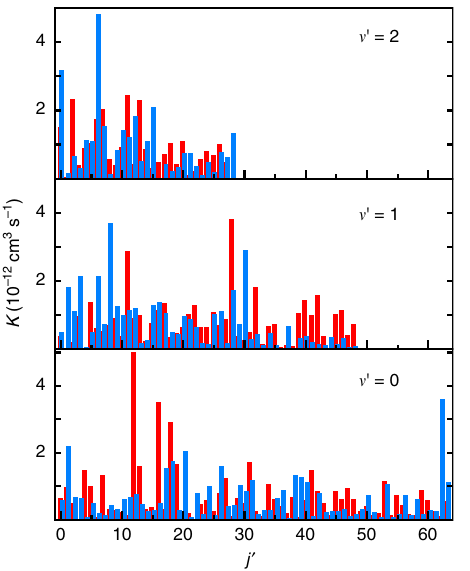
Figure 3 | Rotationally resolved rates. The state-to-state J ¼ 0 EQM reaction rate coefficients from the v ¼ 0, j ¼ 0 ro-vibrational state of KRb to the v 0 ¼ 0, 1 and 2 vibrational level of K 2 as a function of product rotational quantum number j 0 . The blue and red bars are from calculations with the full trimer and additive pairwise potential, respectively. Rates are for an initial collision energy of E / k ¼ 210nK.